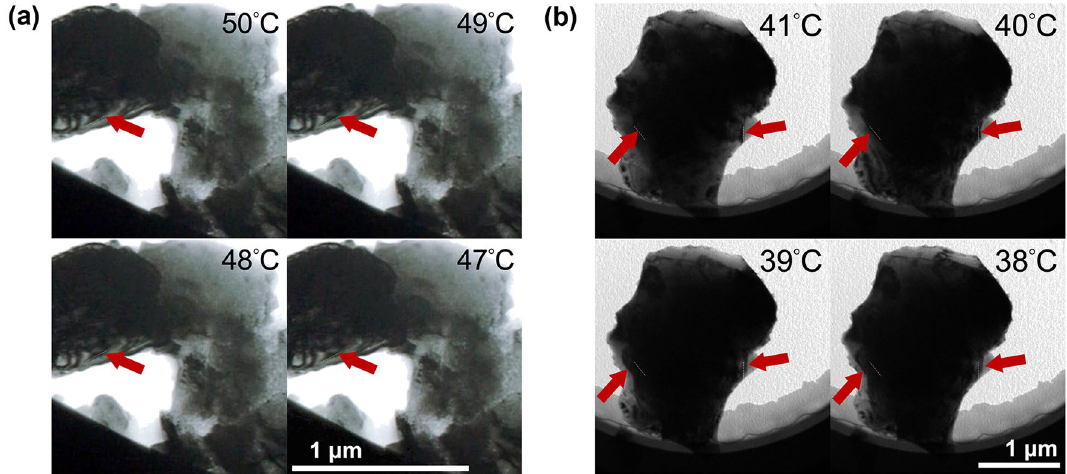
Figure 4. In-situ TEM heating and cooling experiment resulted in structural changes and BF contrast differences allowing for direct observation of the SPT of ( a ) VO 2 and ( b ) W 0.008 V 0.911 O 2 upon cooling with T c occurring at 68 °C. The contrast boundary movement, highlighted using red arrows, was used to calculate approximate rates of transformation to compare to in-situ PDF